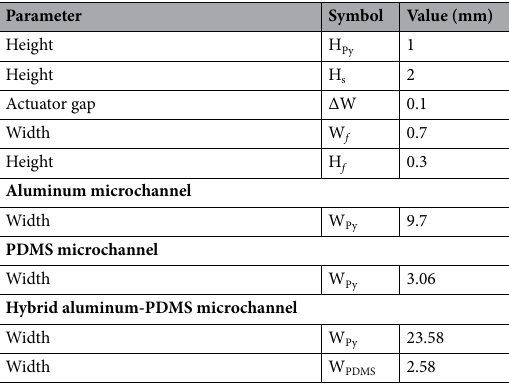
Table 2. Geometrical parameters of different microchannels used in this acoustophoretic study.